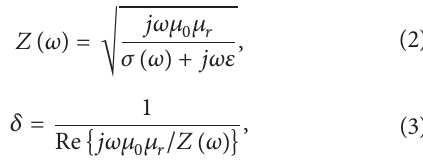
structure for obtaining the given performance. Compared